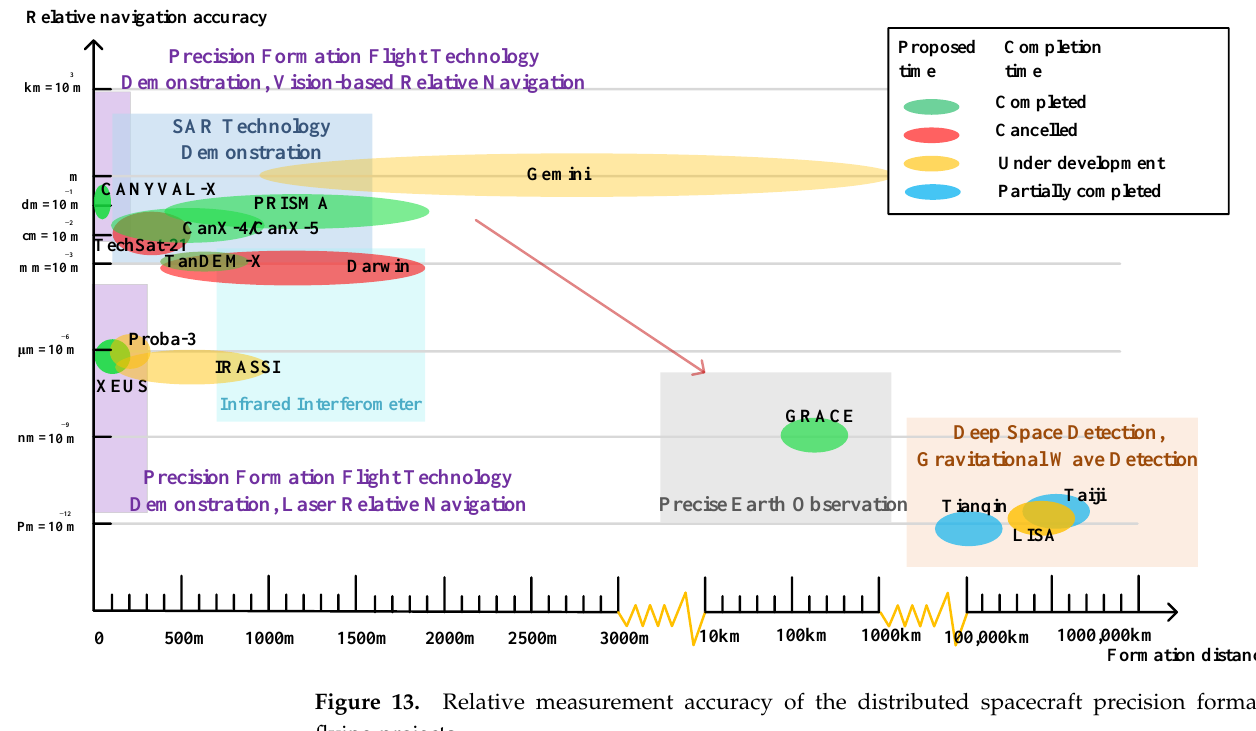
Figure 13. Relative measurement accuracy of the distributed spacecraft precision formation flying projects.